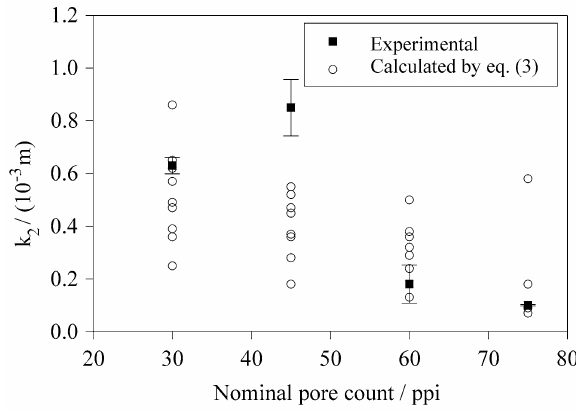
Figure 8. Comparison between experimental and calculated values of the non-Darcian permeability constant k 2 for 30 to 75 ppi ceramic foams.